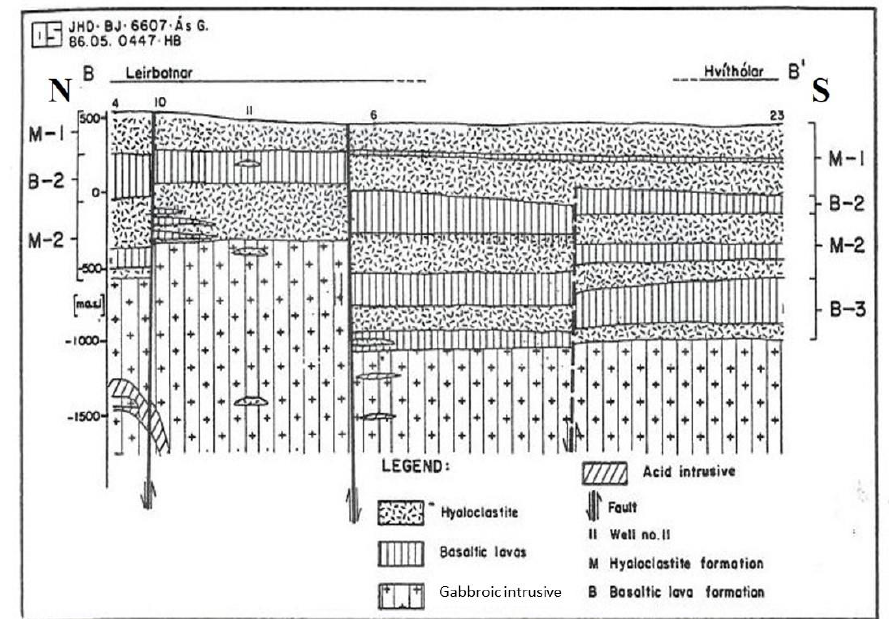
Figure 7. A de-trended residual Bouguer gravity map (mGals) of Krafla volcano. The visible 110 ka caldera rim is shown with heavy black hatched lines. An inferred buried inner caldera rim is shown with lighter black hatched lines, an inferred lower density transverse structure is shown with grey lines and a clear density boundary to the north is shown as grey broken line. The location of the lithological section in Figure 8 is shown by straight black line (black stars are wells on the section). Blue and green lines show faults and fissures, and craters and eruptive fissures and explosion craters are shown with yellow lines. Coordinates are UTM, WGS84, zone 28 in km.